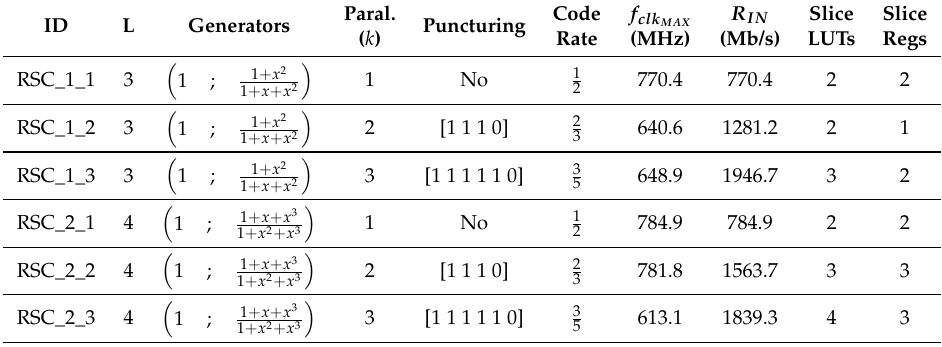
Table 1. Recursive systematic convolutional (RSC) encoders rate, occupation, code rate